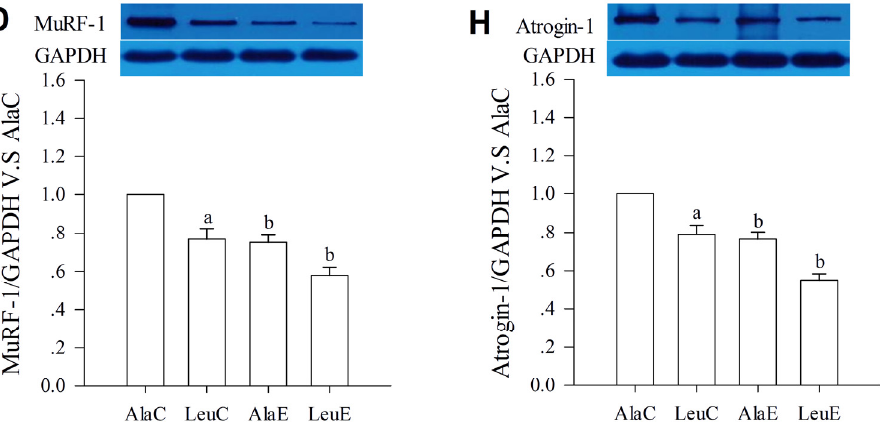
Figure 4. Effects of leucine supplementation and exercise on protein expression with relation to hypertrophy and atrophy. AlaC alanine supplementation group, LeuC leucine supplementation group, AlaE alanine supplementation + exercise training group, LeuE leucine supplementation + exercise training group. ( A ) mVPS34; ( B ) mammalian target of rapamycin (mTOR); ( C ) p70S6K; ( D ) MuRF ‐ 1; ( E ) 4E ‐ BP1; ( F ) MHC; ( G ) Ubiquitin; and ( H ) Atrogin ‐ 1. Values are provided as mean ± standard deviation for each group ( n = 7–10). a: p < 0.05 versus the AlaC group; b: p < 0.01 versus the AlaC group.